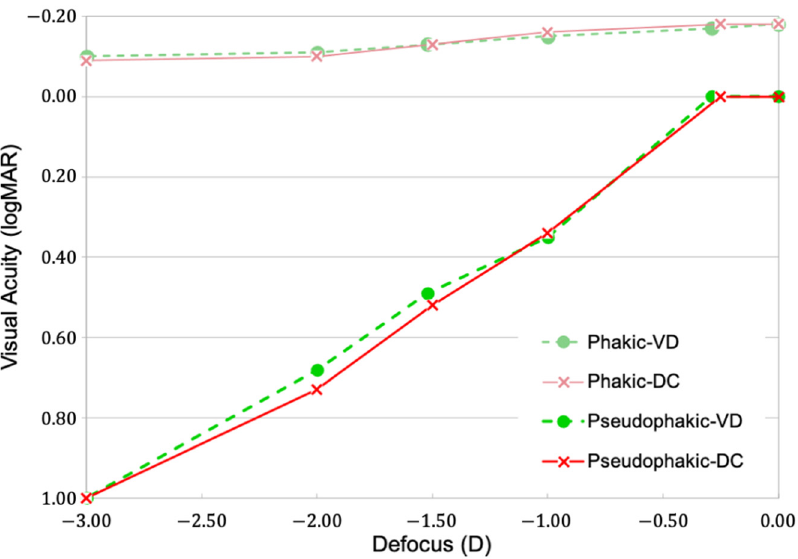
Figure 2. Visual acuity (logMAR, uncorrected results) versus defocus that was obtained with the VD and DC methods for the phakic (with accommodation preserved) and pseudophakic groups. All the measurements were taken with the best distance correction.